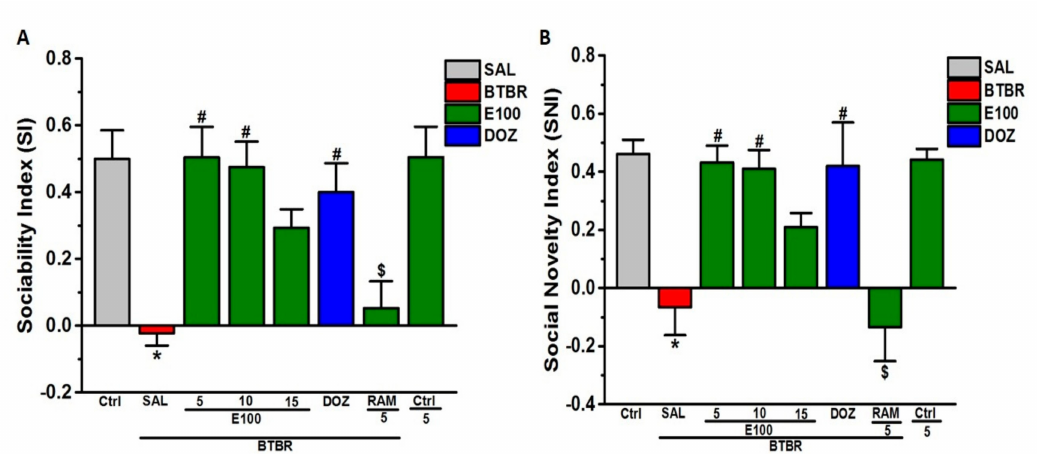
Figure 1. E100-improved sociability and social novelty deficits of BTBR mouse model of autism spectrum disorder (ASD). Mice were allowed to explore all 3 chambers for two cosecutive10 min sessions. The results attained were ( A ) Sociability index (SI) and ( B ) Social novelty index (SNI). C57BL / 6 J (gray) received saline in Ctrl group, E100 (5,10 or 15 mg / kg, i.p. in green) or donepezil (DOZ) (1 mg / kg, i.p. in blue). All mice were treated for 21 days. Abrogative study of subchronic (21 days) systemic co-injection of RAM (10 mg / kg, i.p.) on the E100 (5 mg) provided improvement of ( A ) sociability and ( B ) social novelty. Values expressed as mean ± SEM (n = 5). * p < 0.05 compared to SI or SNI of saline-treated Ctrl mice. # p < 0.05 compared to SI or SNI of saline-treated BTBR mice. $ p < 0.05 compared to E100 (5 mg)-treated BTBR